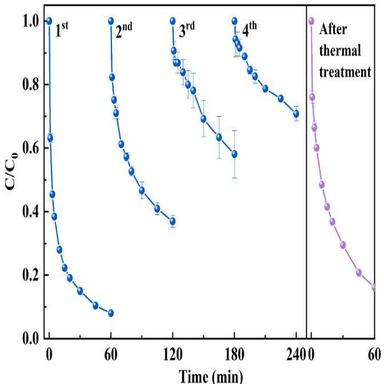
Reusability of CPANI. Experimental conditions: = 25 mg L− 1 , = 10 μM, = 0.5 mM, and initial pH of 7.0.